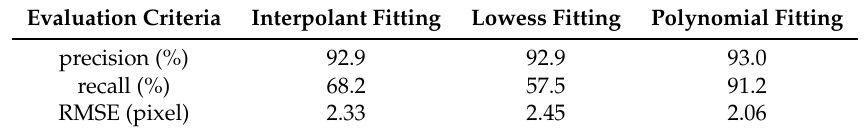
Table 2. Mean precision, recall and RMSE values in Interpolant fitting, Lowess fitting and Polynomial fitting with m set to 3.